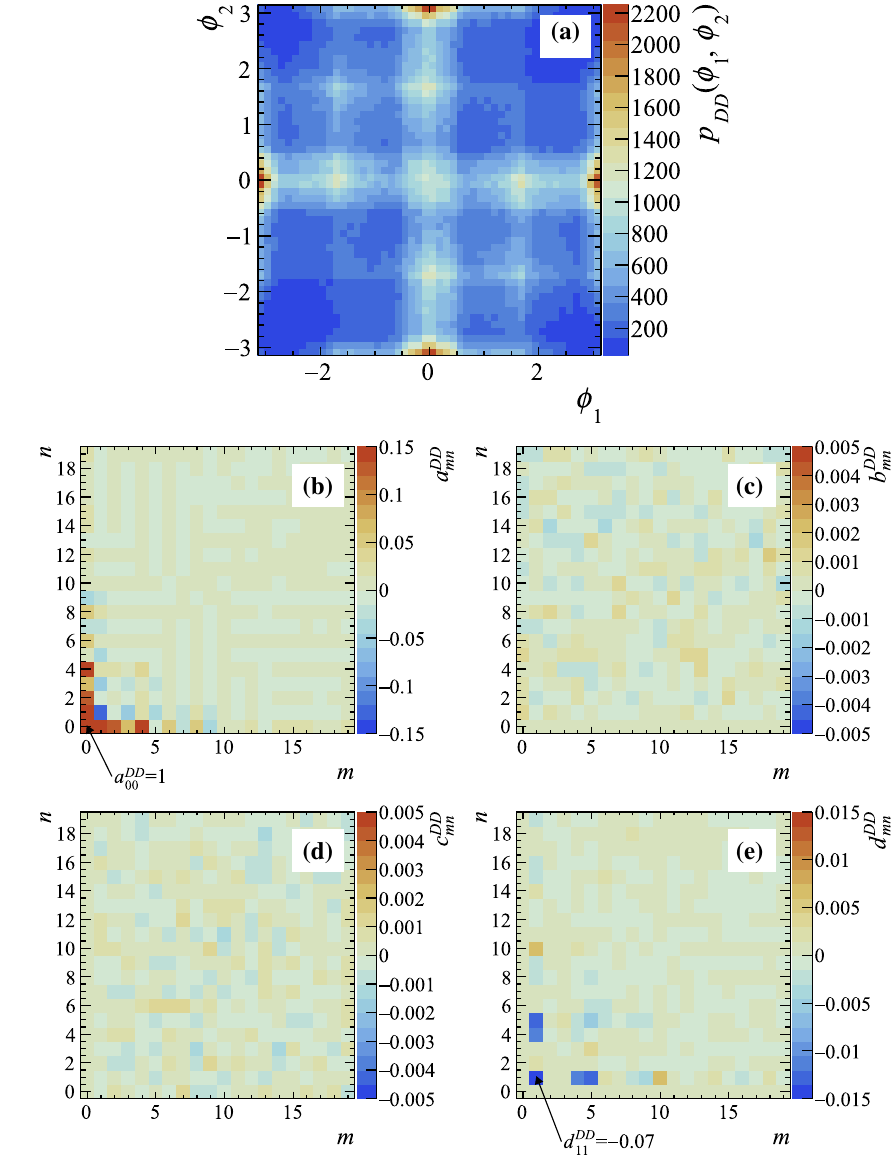
Fig. 2 a The function p DD (φ 1 ,φ 2 ) according to a model obtained by the Belle collaboration [14], and b – e its Fourier series coefficients. The ranges of the plots for a DD mn and d DD mn are chosen such that the = 1 dominant components a DD 00 = − 0 . 07 fall out of and d DD 11 the range, to make the other components